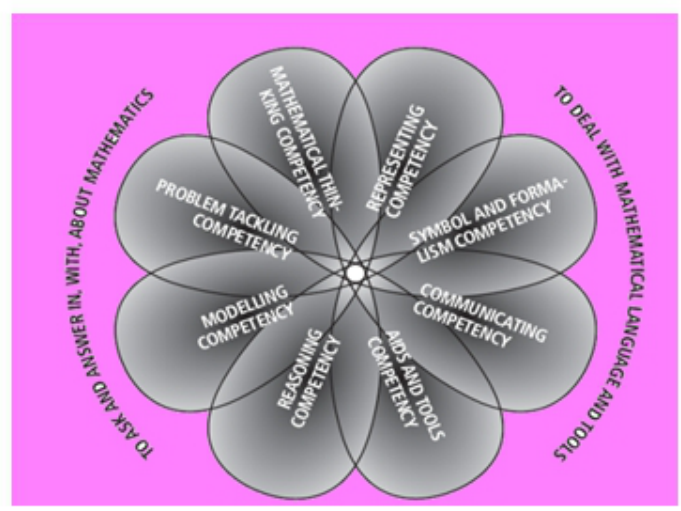
Figure 1. Mathematical competences (KOM